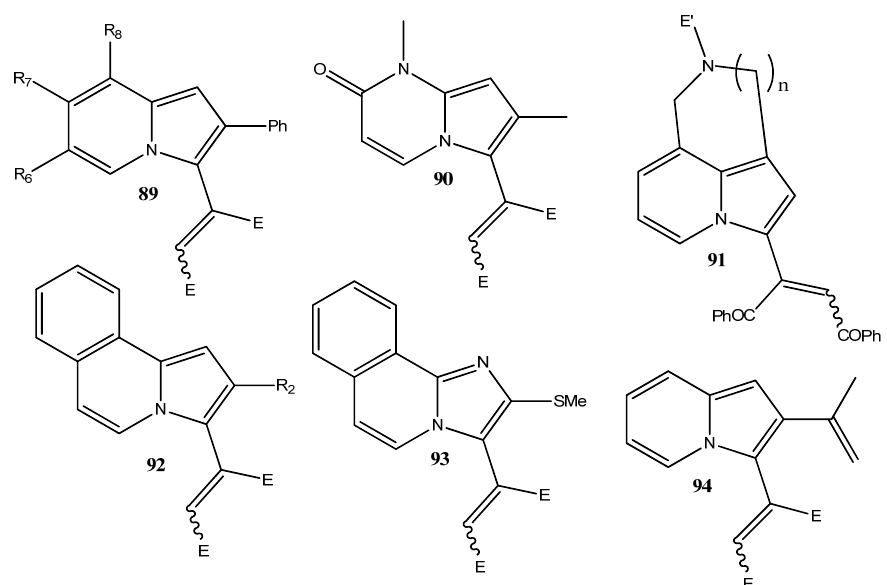
Table 24. Stereochemistry, conditions and yields of synthesis of vinyl indolisines on Scheme 52. N R Yield (trans/cis), % Conditions Ref. 89a R = H 13:4